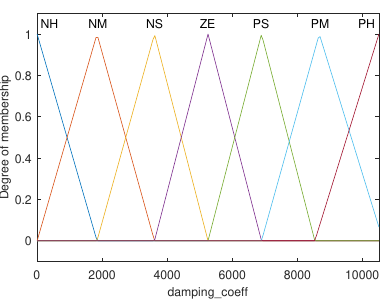
Figure 6. Membership Function of o / p variable “Damping Co- e ffi cient”